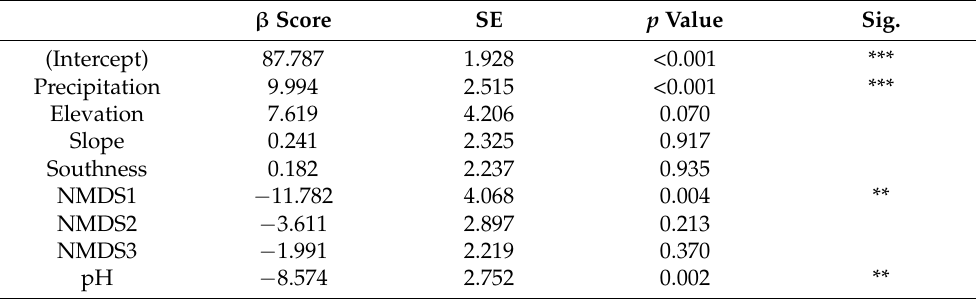
Table 3. Results of the generalized linear model accounting for the stock of soil organic